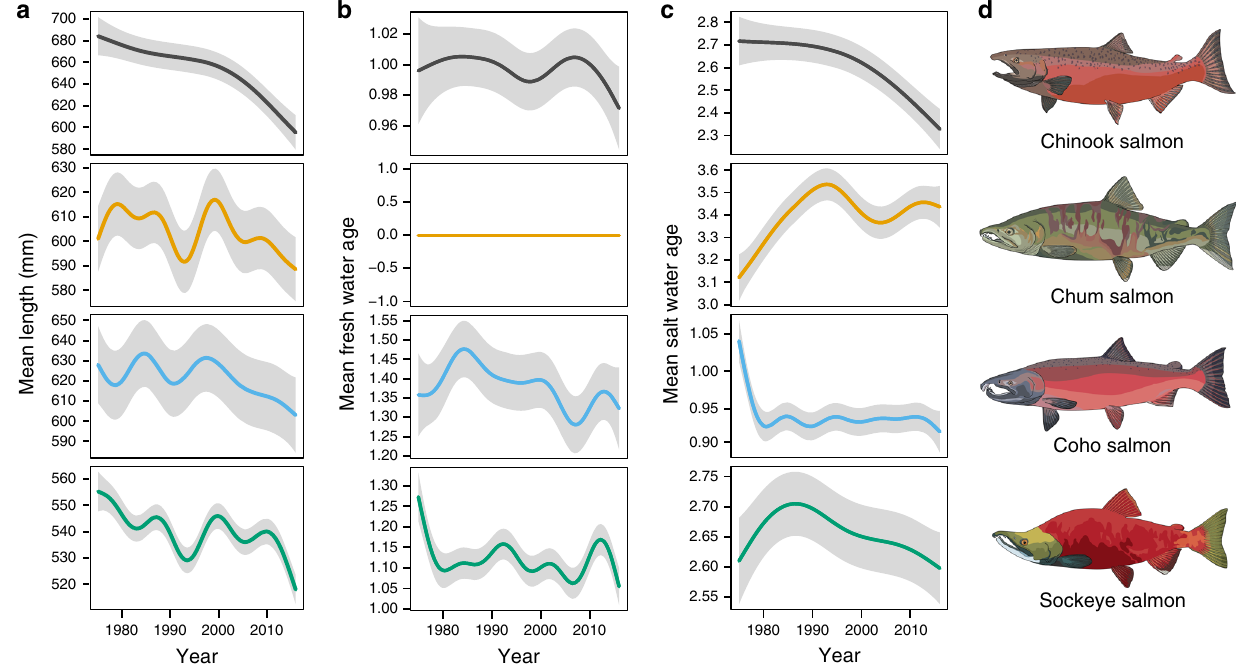
Fig. 2 Body size declines are signi fi cant and nonlinear. a Mean fi sh length has changed in a nonlinear pattern, as demonstrated by the nonlinear year effect from GAMs on mean population length with fi xed effects of region and population. b Mean freshwater age (in years) has generally declined, except for chum salmon, which leave freshwater shortly after emergence. c Mean saltwater age (in years) has also generally declined, except in chum salmon, which increased in saltwater age until around 1990, then decreased. Plots are conditioned on reference populations with the longest time series for each species, but the pattern plotted is the common pattern through time calculated for all populations. Gray areas represent 95% con fi dence intervals for the nonlinear year effect. d Male salmon in spawning coloration. Sample sizes are presented in Supplementary Data 5.